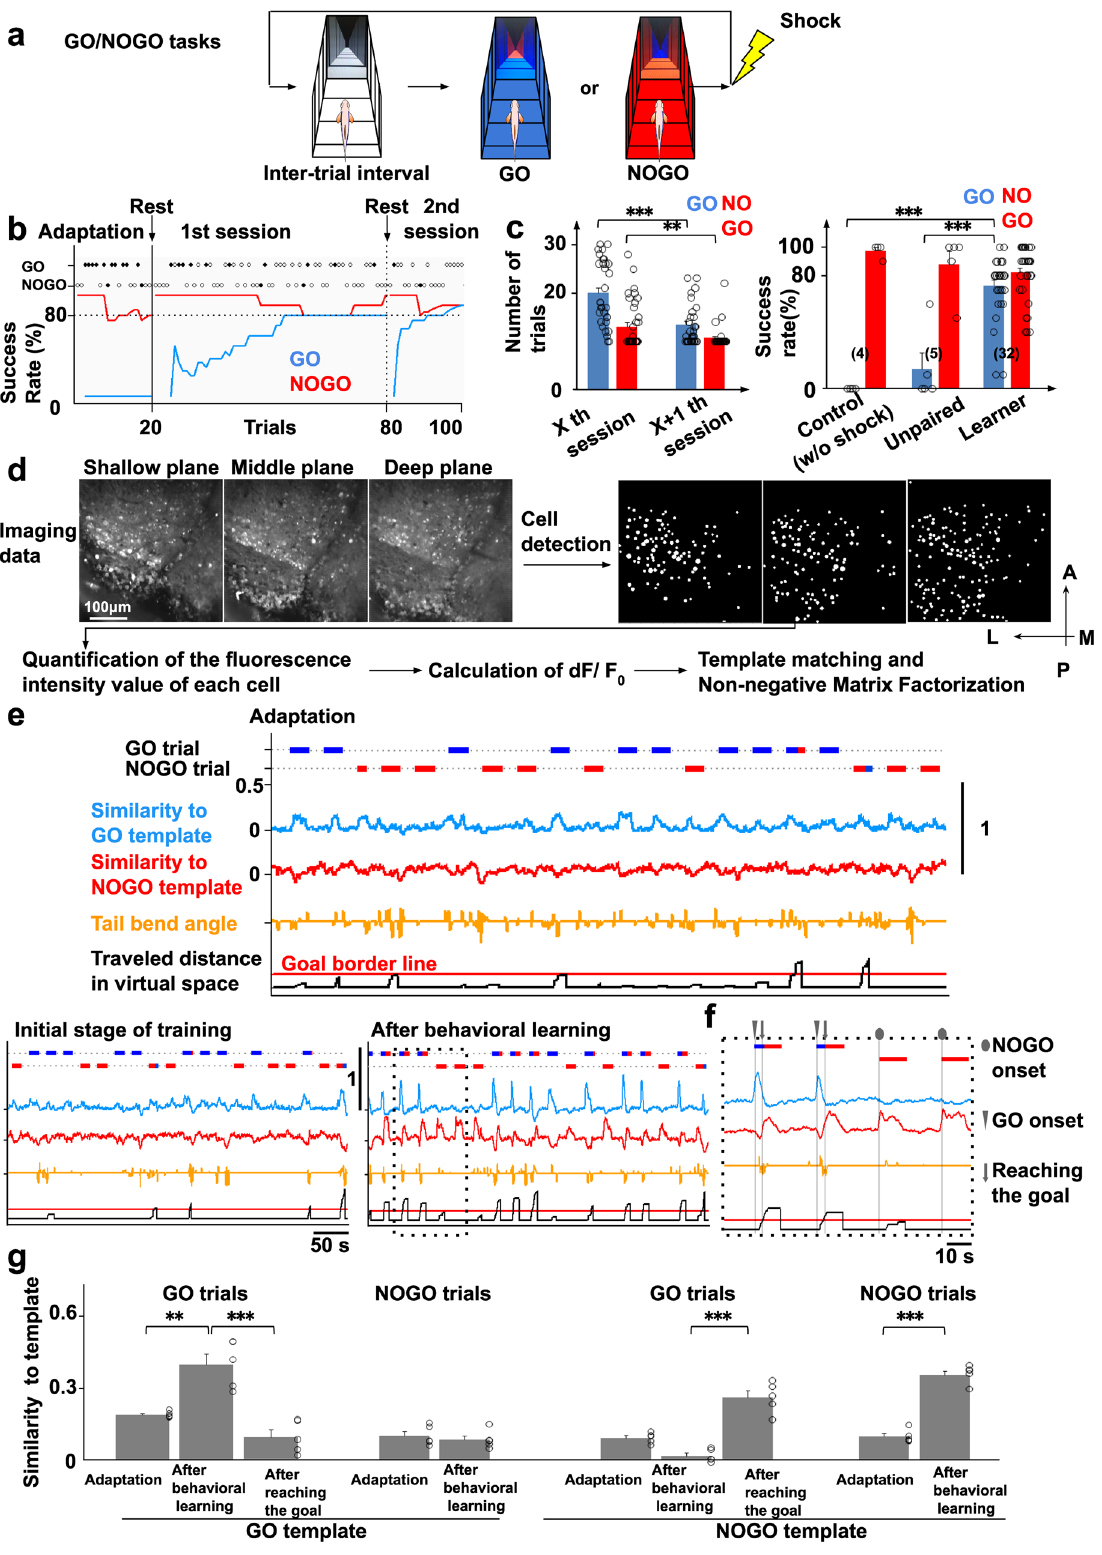
beginning. However, as training proceeded, the fi sh gradually succeeded in the GO trials and eventually, the success rate of both GO and NOGO trials met the learning criterion, i.e., 80%, in both trials, calculated from the past ten trials. We regarded that the fi sh had learned at this time point. In the second session, the success rate of both GO and NOGO trials met the learning